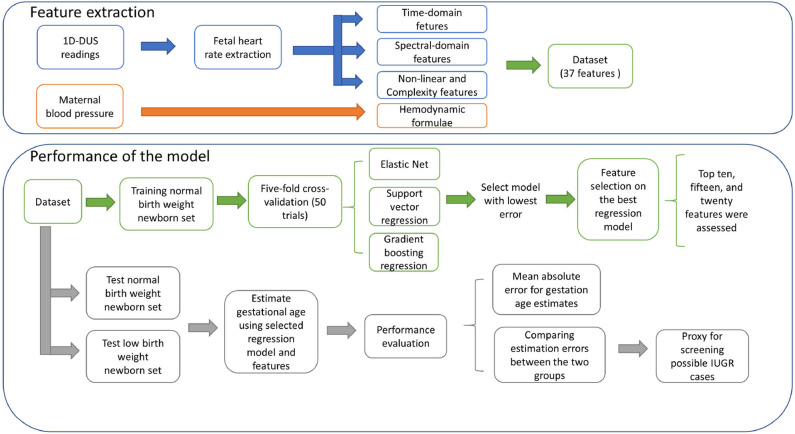
Block diagram of the approach for detecting possible cases of IUGR.